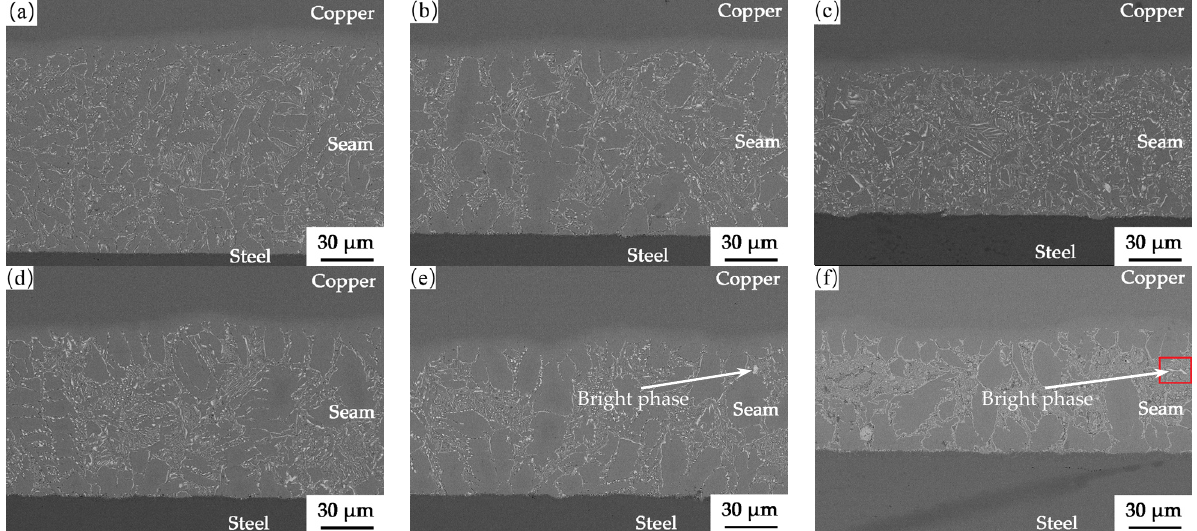
Figure 7. Microstructure of the copper/304 stainless steel joints using different low-silver filler metals: ( a ) 12AgCuZnSn-1In-0.1Pr, ( b ) 12AgCuZnSn-2In-0.1Pr, ( c ) 12AgCuZnSn-2In-0.15Pr, ( d ) 12AgCuZnSn-2In-0.3Pr, ( e ) 12AgCuZnSn-2In-0.5Pr, ( f ) 12AgCuZnSn-5In-0.5Pr.